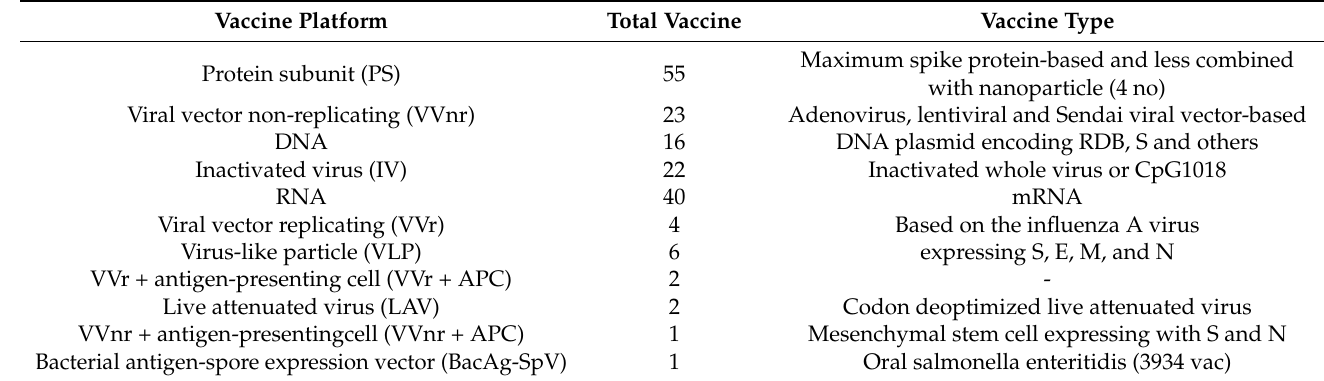
Table 1. The summary vaccines and its